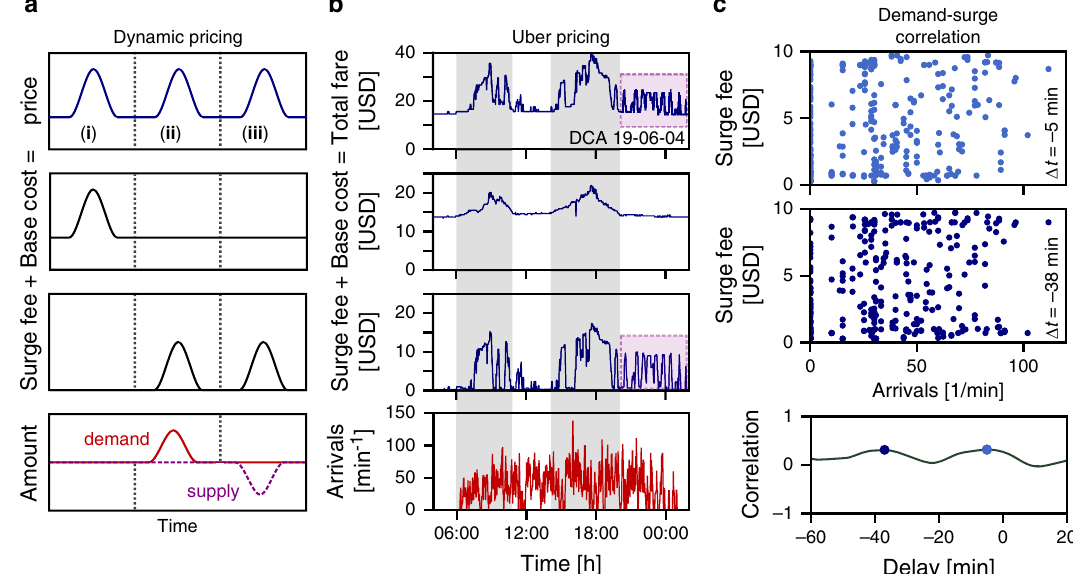
Fig. 1 Dynamic pricing in on-demand mobility. a Schematic illustration of dynamic pricing. The total price separates into the base cost of the product or service and a supply and demand-dependent surge fee. Three fundamental mechanisms underlying price changes are (i) changes of the base cost, (ii) demand exceeding current supply levels, and (iii) supply shortage compared to current demand. Price adaptations (ii) and (iii) are intended to drive the system back to a supply – demand equilibrium. b The total fare for Uber ride-hailing services similarly decomposes into base cost and surge fee. Base cost depend on trip duration and re fl ect current traf fi c conditions while surge fees result from supply – demand imbalances. Both effects are illustrated here for trips from Reagan National Airport (DCA) to Washington Union Station in Washington, DC, USA. During commuting hours base cost increase because of longer expected trip duration during rush-hour (gray shading). The slower speed effectively reduces the supply of available drivers as they spend more time in traf fi c and naturally causes accompanying surge fees. During late evening and nighttime, the total fare exhibits repeated price surges triggered by supply – demand imbalances (dashed box) not re fl ected in the demand dynamics (passenger capacity of airplanes landing in DCA), consistent with